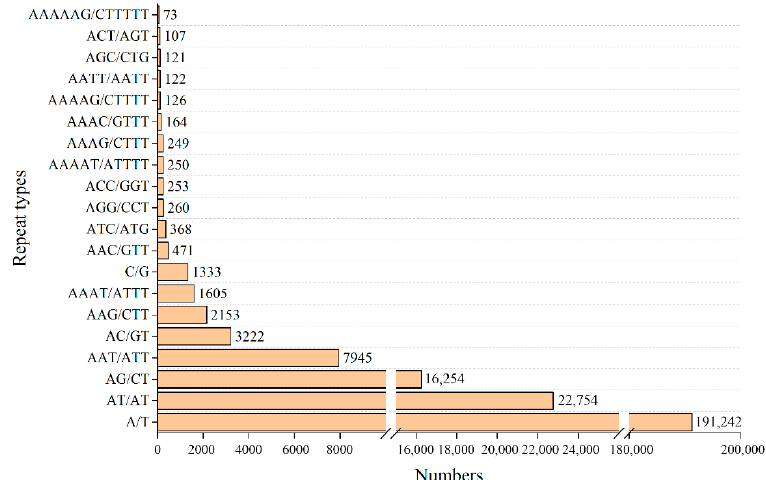
Figure 5. Top 20 frequency of B. platyphylla SSR types (considering sequence complementary).